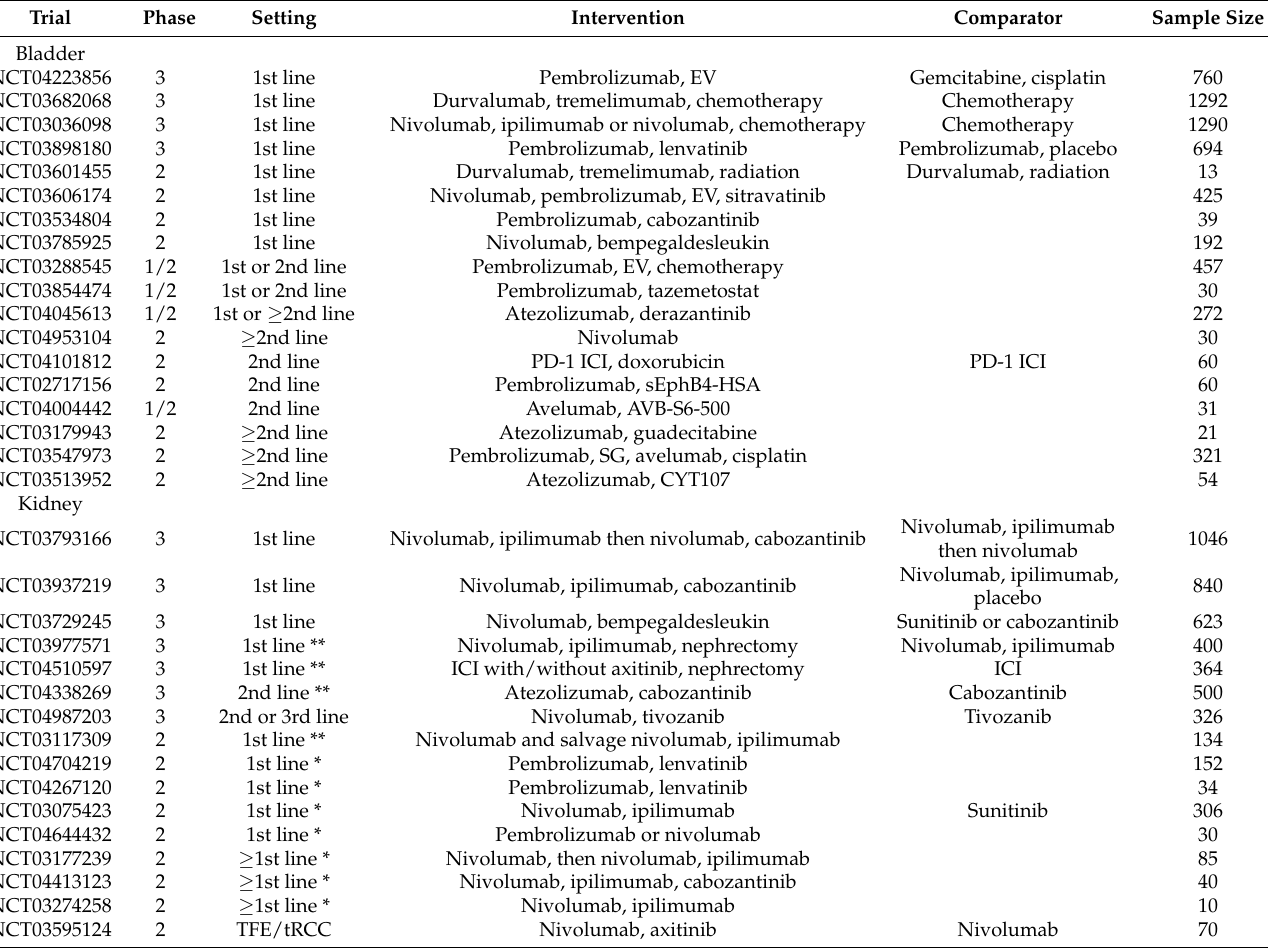
Table 4. Ongoing immune checkpoint inhibitor trials for metastatic genitourinary cancers.